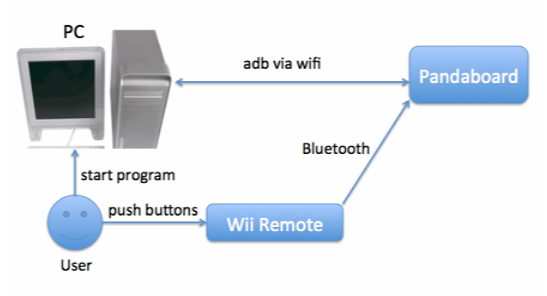
Fig. 3. system configuration